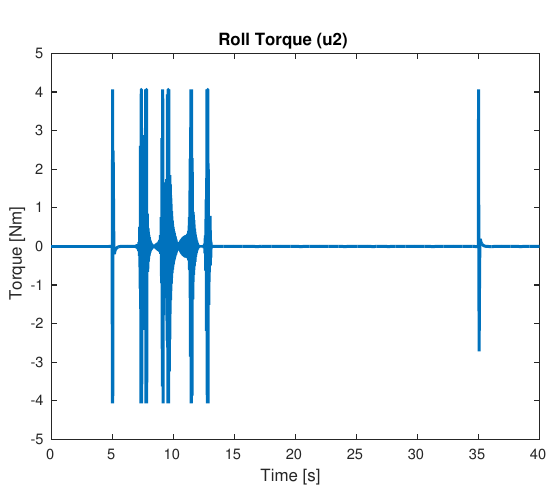
Figure 30. Vertical Thrust u 1 .